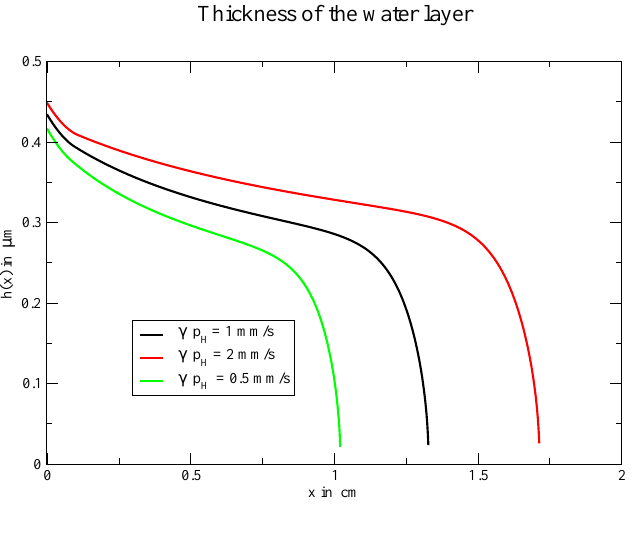
Figure 4: The shape of the water layer for some values of γ and skating conditions